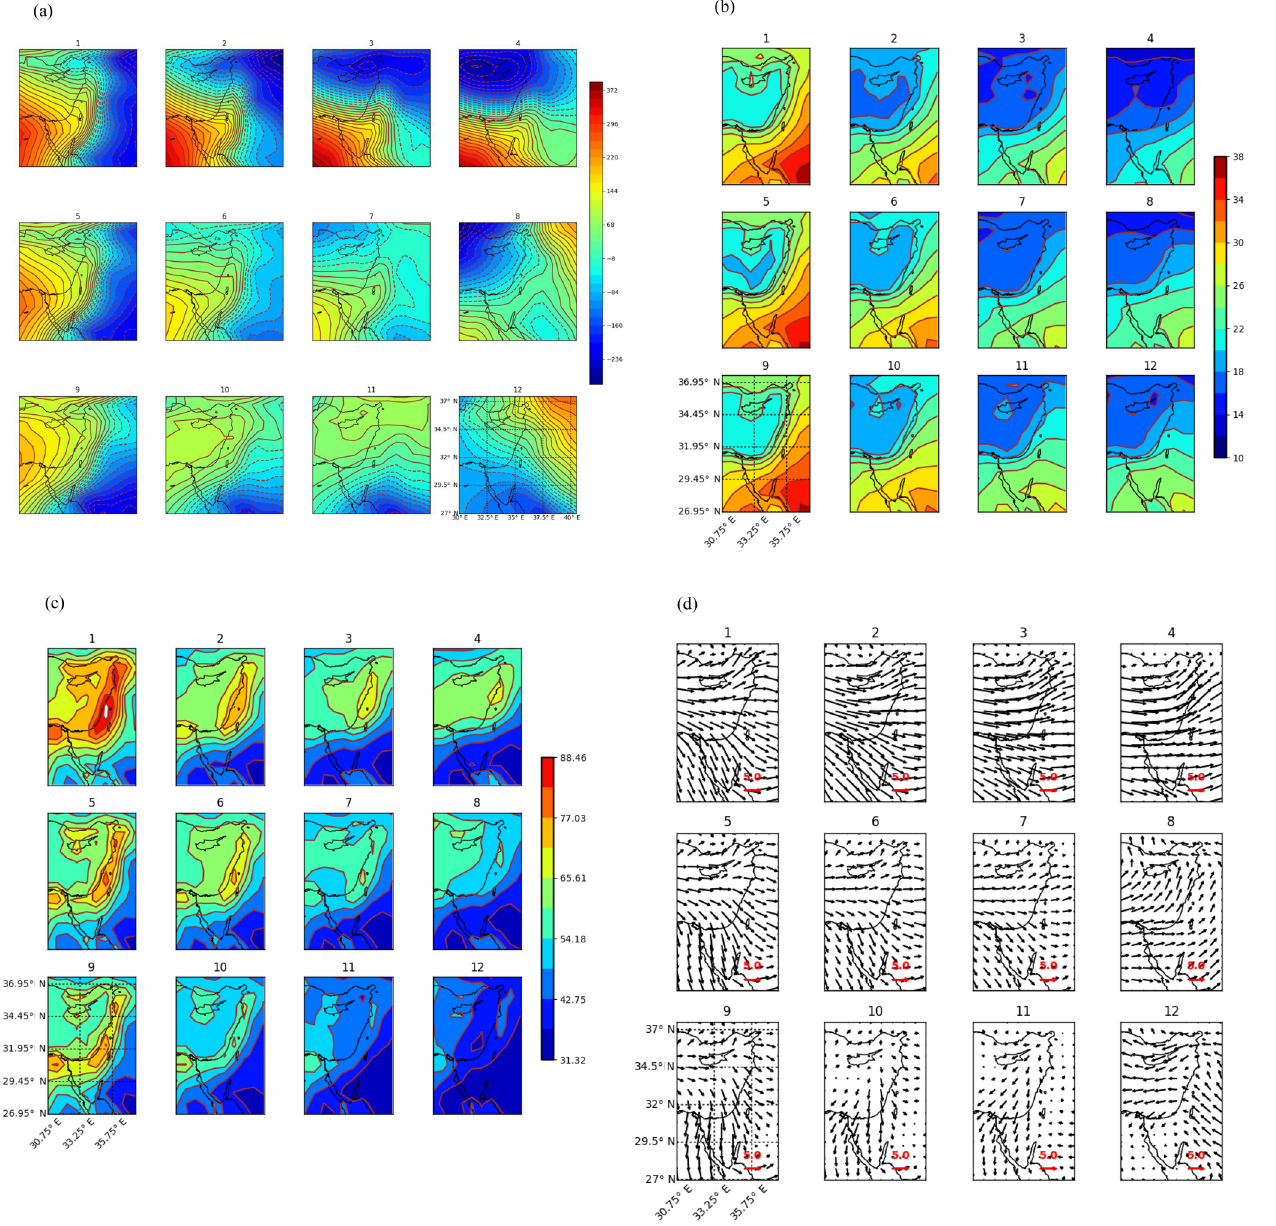
Figure 4. 12:00UTC winter spring and autumn, ERA-INTERIM averages according to 4 × 3 SOM wind regimes (displayed in Fig. 2). The node number is shown at the top of each sub-figure. (a) Average geopotential height anomalies over the EM [m 2 s − 2 ] at 925hPa. (b) Average temperature [ ◦ C] at 1000hPa. (c) Average specific humidity [dgkg − 1 ] at 925hPa. (d) Average synoptic wind [ms − 1 ] at